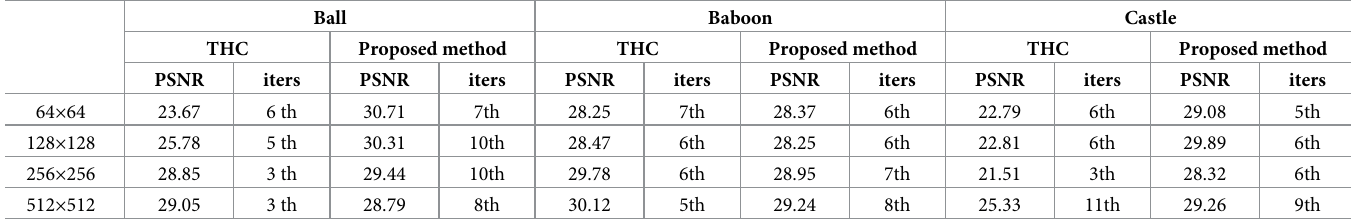
Table 1. Performance comparison on different examples and different image sizes using our algorithm and the THC algorithm. Ball Baboon Castle THC Proposed method THC Proposed method THC Proposed